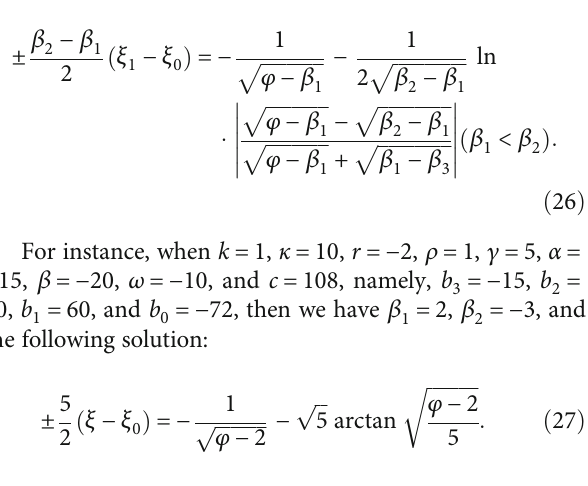
1 ffiffiffiffiffiffiffiffiffiffi